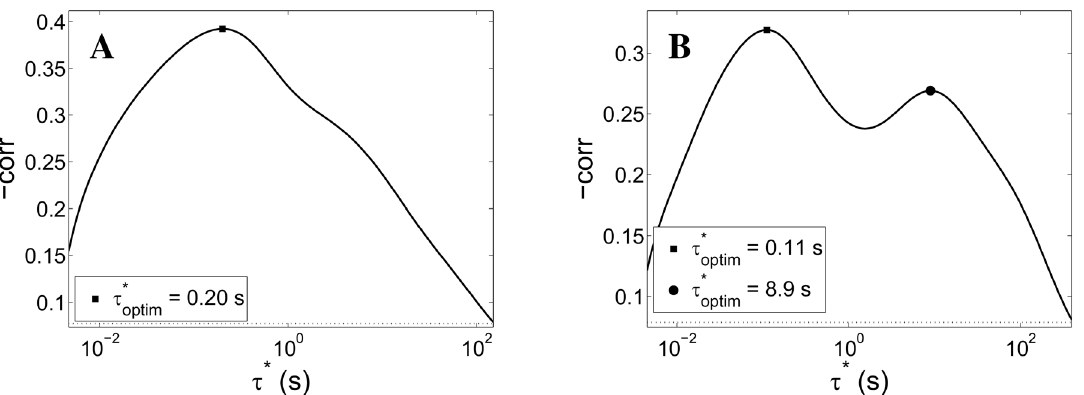
Fig 8. Slow time-scales inference procedure on ex-vivo data. Correlation between low-pass filtered network activity f (see Eq 19) and the size of the immediately subsequent network spike plotted against the time-scale τ * of the low-pass integrator for two experimental datasets (different periods — about 40 minutes each — in a long recording). The plot in panel A is qualitatively similar to the simulation result shown in panel A of Fig 7: a peak, although broader and of smaller maximum (absolute) value, is clearly identified and statistically significant (with respect to surrogate data, dotted line). Panel B shows two significant peaks in the correlation plot, a possible signature of two concurrently active fatigue processes, with time scales differing by roughly an order of magnitude. Panel A: same data as Fig 5, panel B.